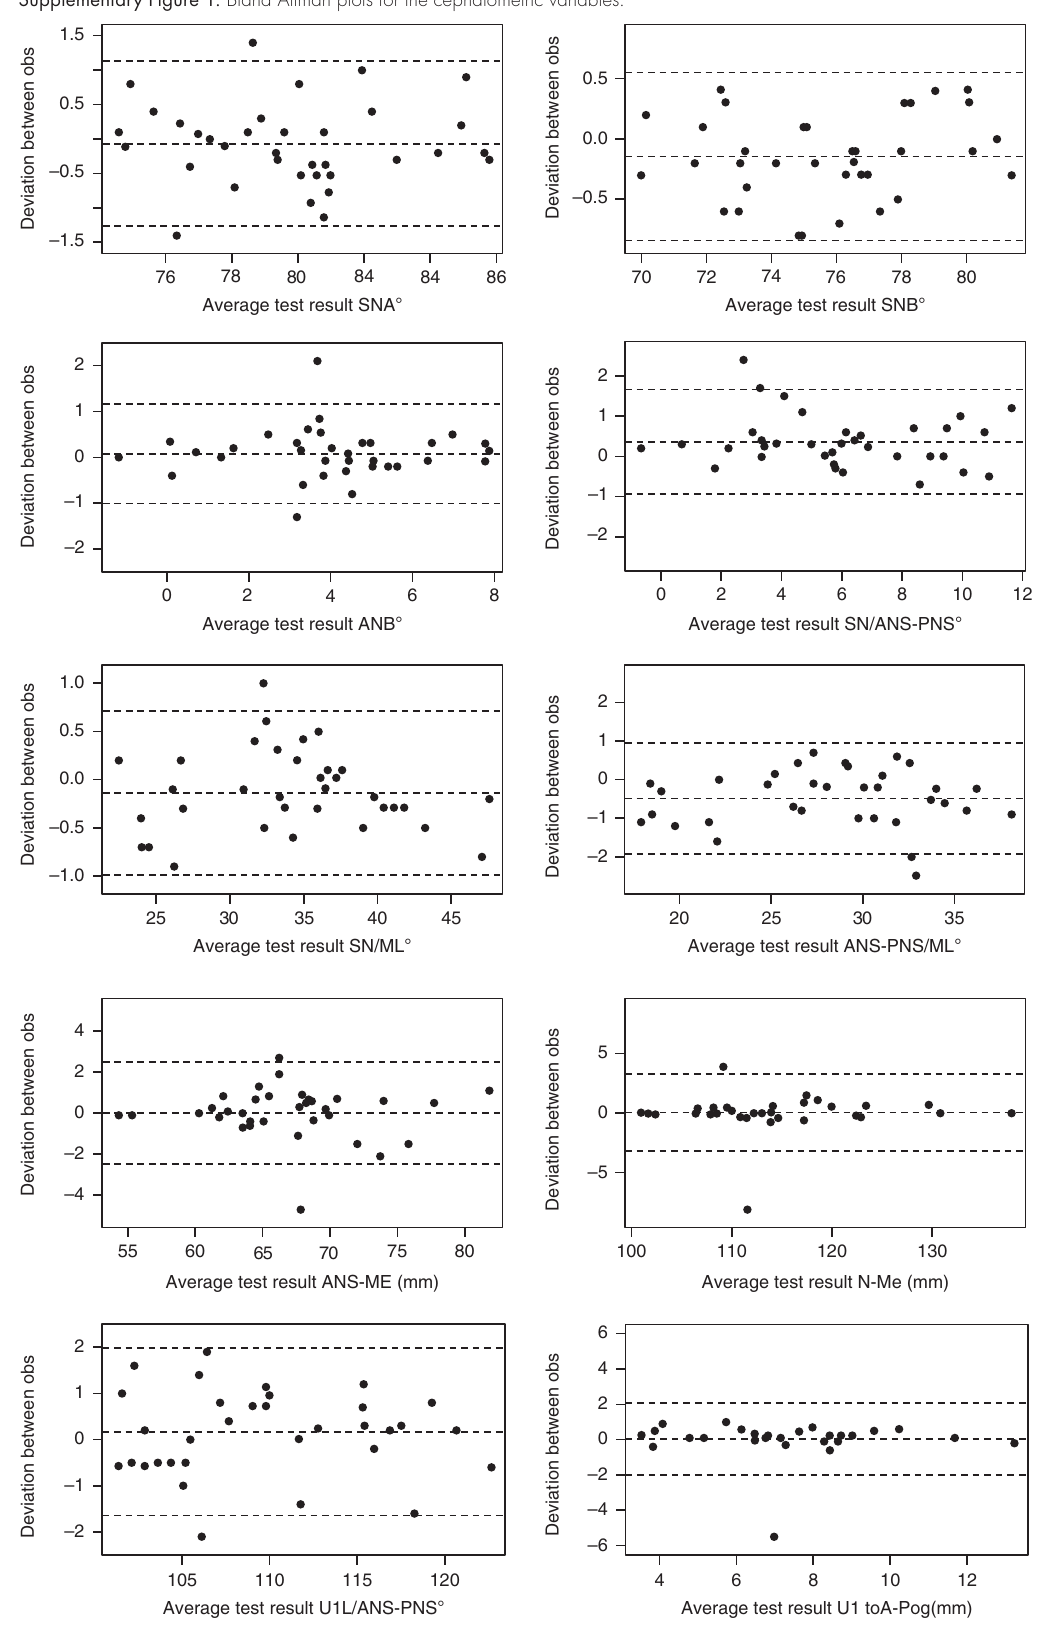
Supplementary Figure 1. Bland Altman plots for the cephalometric